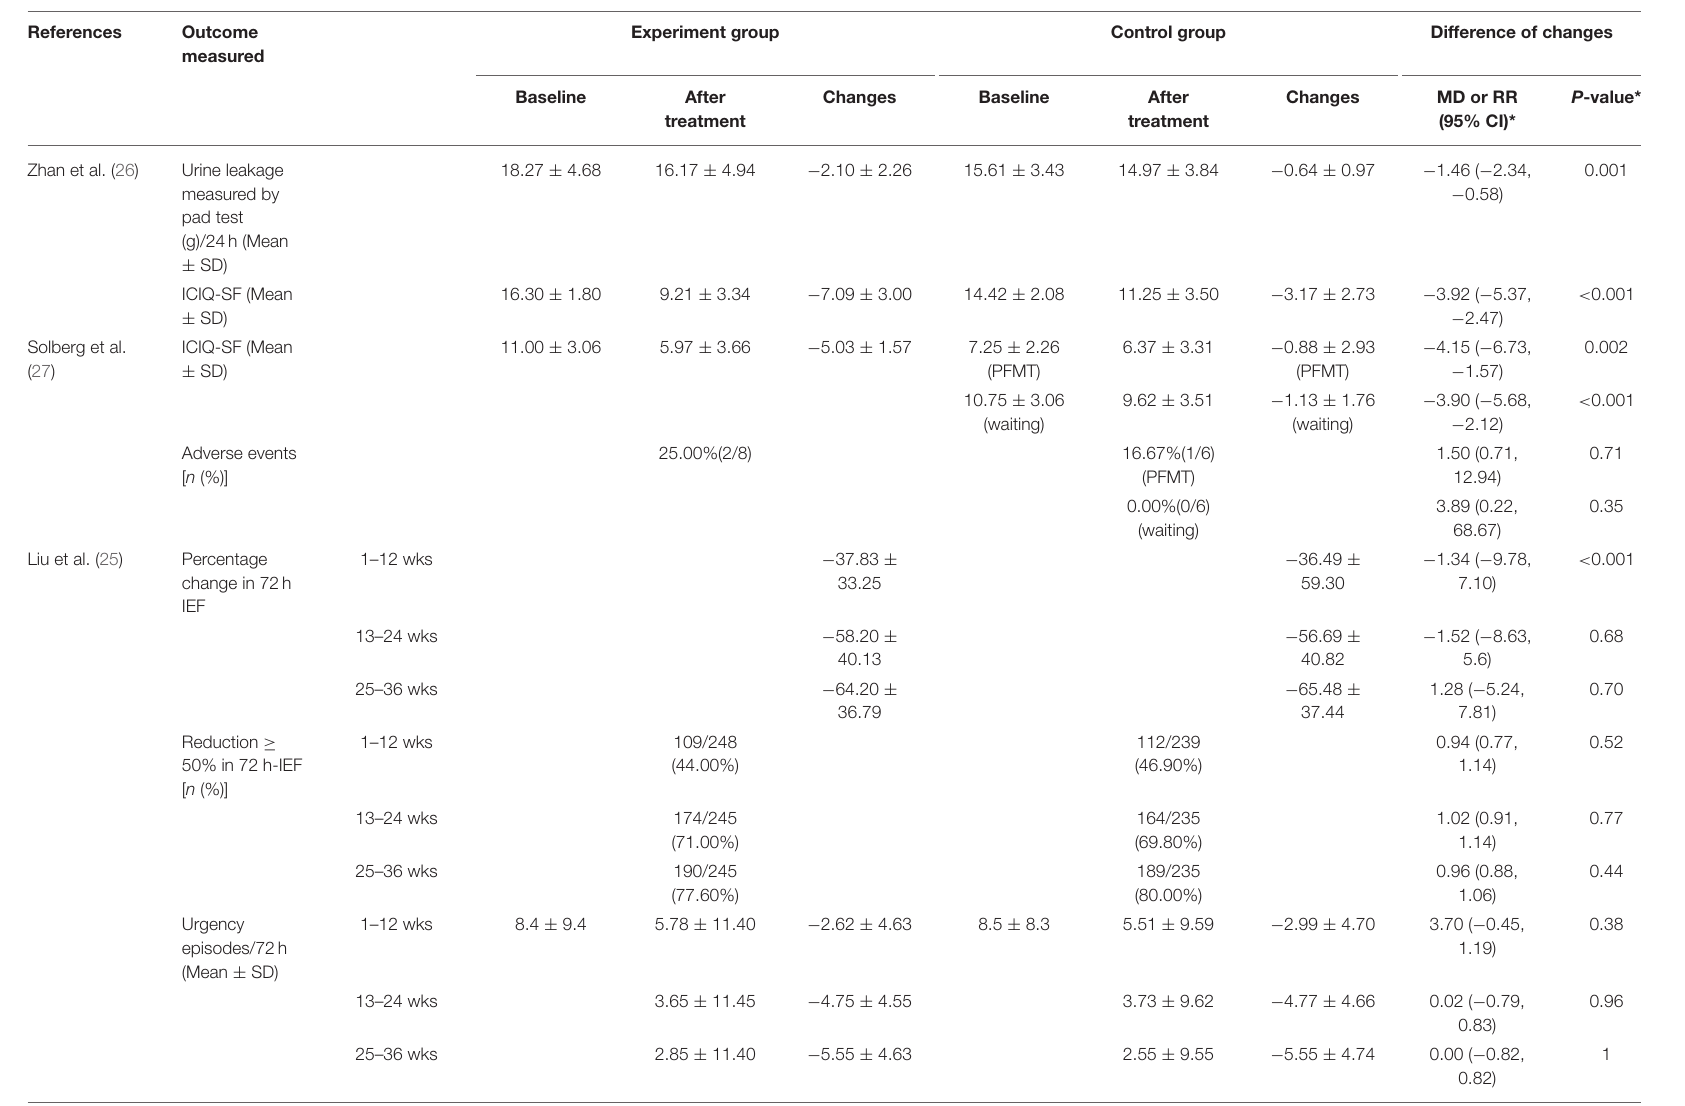
TABLE 2 | Summary of